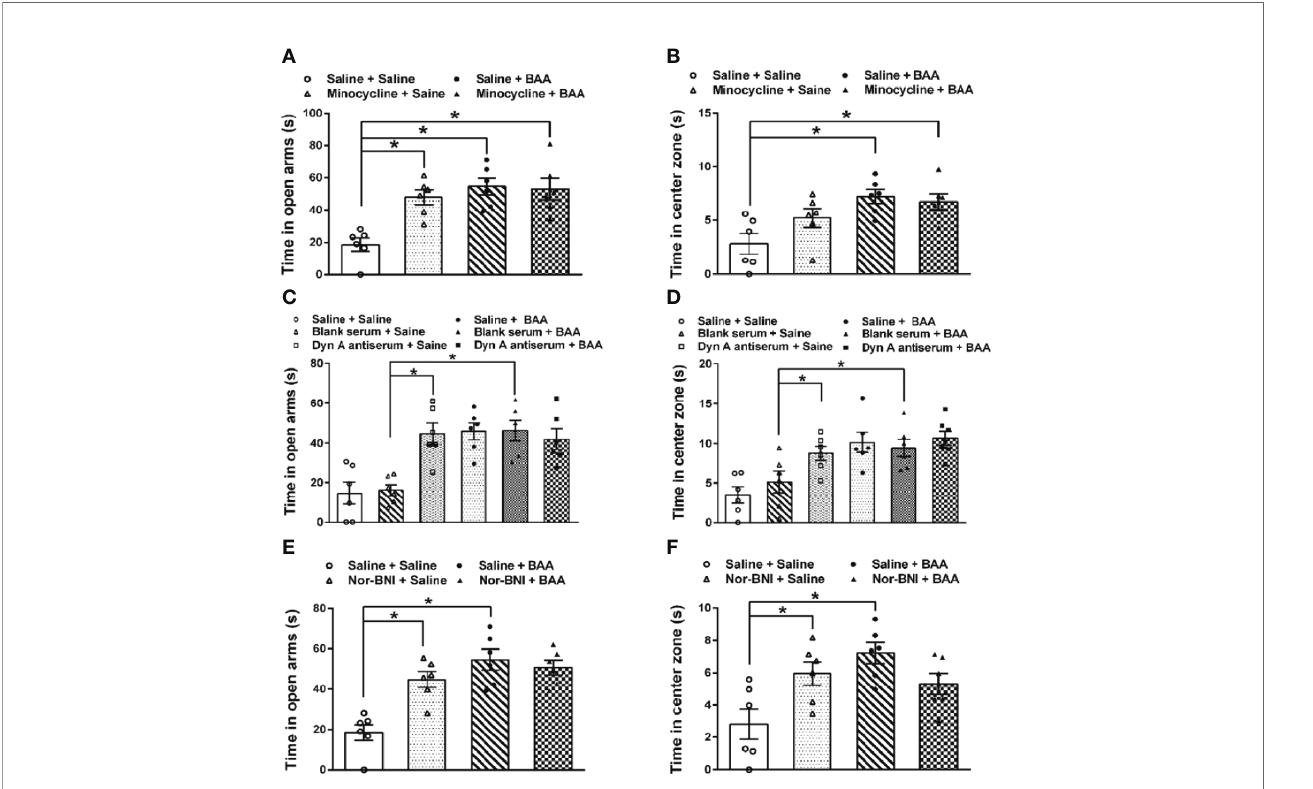
FIGURE 5 | The effects of microglia inhibitor minocycline, dynorphin A antiserum, and k opioid receptors inhibitor nor-binaltorphimine dihydrochloride (nor-BNI) on the antianxiety effect of Bulleyaconitine A (BAA). (A) Bars showing that in the elevated plus maze (EPM) test, both BAA and minocycline produced signi fi cantly antianxiety effects on 2,4,6-trinitrobenzene sulfonic acid + heterotypic intermittent chronic stress (TNBS+HeICS) rats (n = 6 each; one-way ANOVA; * P < 0.05). (B) Bars showing that in the open fi eld test (OFT), minocycline did not in fl uence the antianxiety effect of BAA (n = 6 each; one-way ANOVA; * P < 0.05). (C) Bars showing that both the administration of dynorphin A antiserum and BAA increased time spent in the open arms of the EPM test. (n = 6 each; one-way ANOVA; * P < 0.05. (D) Bars showing that both the administration of dynorphin A antiserum and BAA increased time spent in center zone of the OFT (n = 6 each; one-way ANOVA; * P < 0.05. (E) Bars showing that in TNBS + HeICS rats, both the injection of nor-BNI or BAA increased time spent in open arms of EPM signi fi cantly (n = 6 each; one- way ANOVA; * P < 0.05). Moreover, the administration of BAA and nor-BNI together did not exert more effective antianxiety effects. (F) Bars showing that in TNBS + HeICS rats, both the injection of nor-BNI or BAA increased time spent in center zone of OFT (n = 6 each; one-way ANOVA; * P < 0.05). Moreover, the administration of BAA and nor-BNI together did not produce more effective antianxiety effects. The data are presented as means ± standard error of means